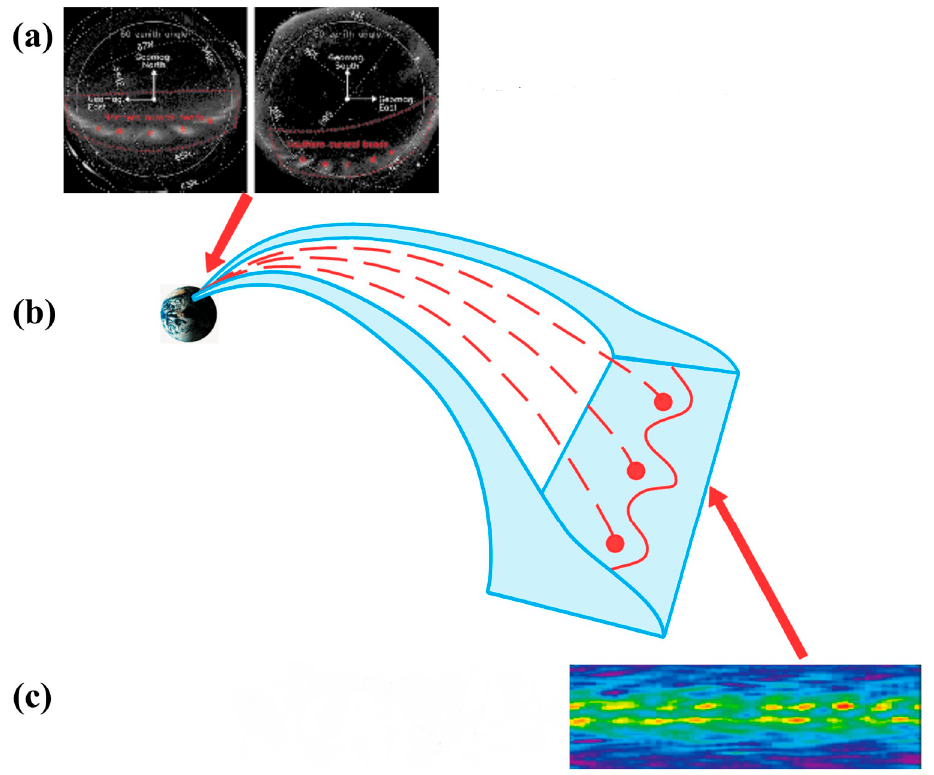
Figure 9. ( a ) A schematic diagram to show the conjugacy of auroral beads by ground-based obser- vations from both northern and southern hemispheres, ( b ) the wavelengths in the magnetospheric equatorial plane corresponding to the periodic structure of the auroral beads, and ( c ) the current filamentation and electron acceleration arising from CCI